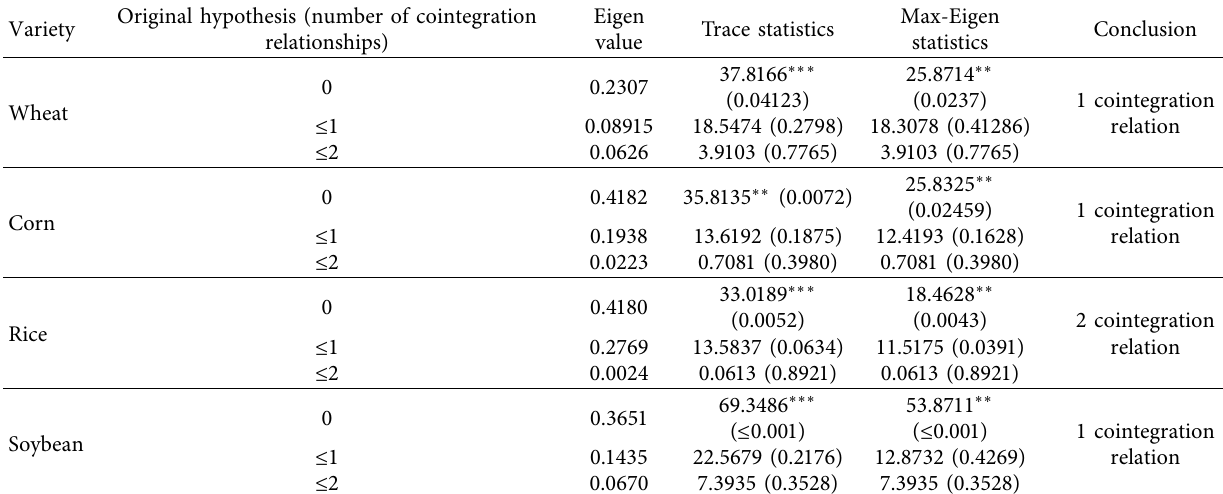
Table 4: Results of the Johansen cointegration